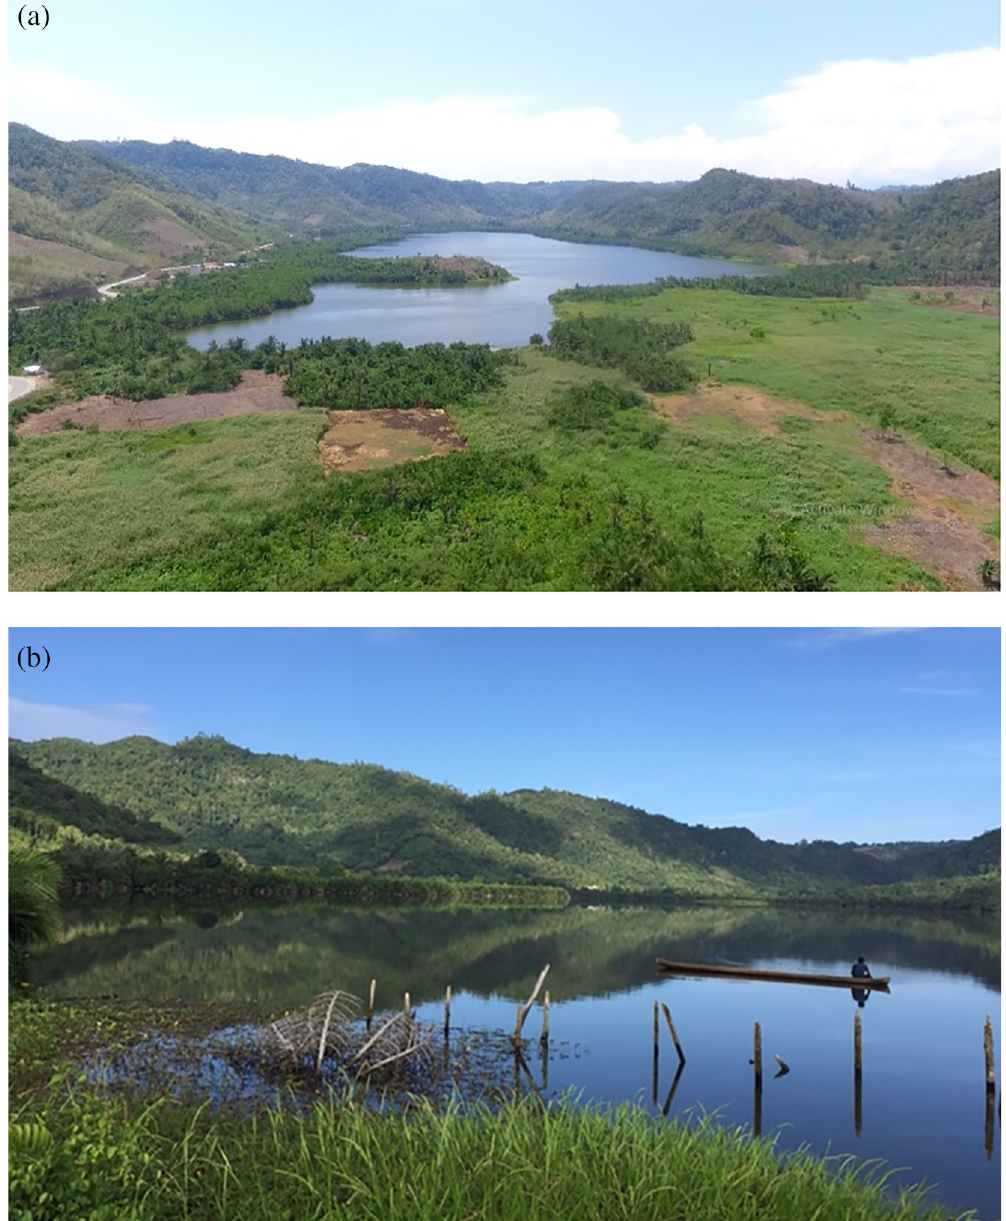
Figure 7. Photographs of Bolano Sau Lake in Central Sulawesi, Indonesia show extensive deforestation (a) and riparian wetlands with few remaining sago palms (b). (Photographs taken by Samliok